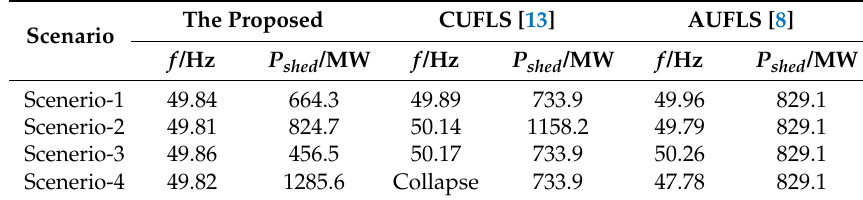
Table A2. The total LS amount and steady-state frequency of each strategy under various scenarios.